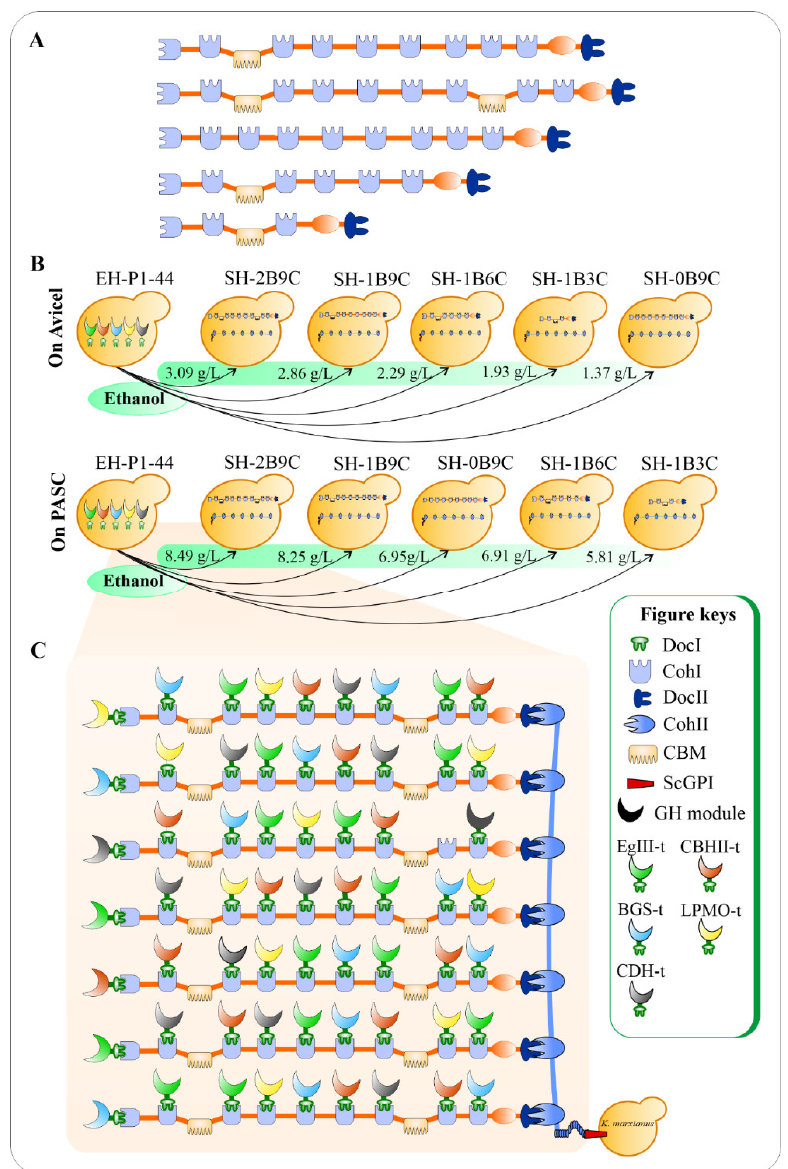
Figure 12. Engineered K. marxianus carrying the largest cellulosome complex on its cell surface. ( A ) (from the top) Full-length of CipA with 1 CBM3a (1B9C), full-length of CipA with 2 CBM3a(s) (2B9C), full-length of CipA without CBM3a (0B9C), truncated CipA with 6 CohI(s) + 1 CBM3a (1B6C), and truncated CipA with 3 CohI(s) + 1 CBM3a (1B3C), respectively. ( B ) Ethanol productivity of different engineered K. marxianus strains. On Avicel, the SH-2B9C strain yielded the highest ethanol titer, followed by the SH-1B9C strain, and the lowest ethanol concentration was found in SH-0B9C which does not have any CBM, indicating the decisive role of a CBM in crystalline cellulose hydrolysis. On PASC, however, the lowest ethanol titer was recorded in SH-1B3C strain, suggesting that the numbers of catalytic subunits, but not CBM3a(s), dictate the efficiency of amorphous cellulose solubilization. ( C ) The engineered K. marxianus with the whole cellulosome complex consisting of total 63 enzyme subunits from divergent species on its surface. Abbreviations in the Figure 12: B, Carbohydrate-binding module; C, Cohesin.